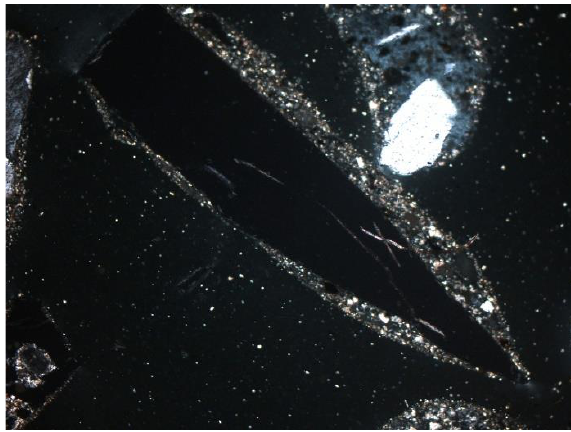
Figure 17. Glass in SP3 slag and ash sample, thin section, 2P, 100×, transmitted light.